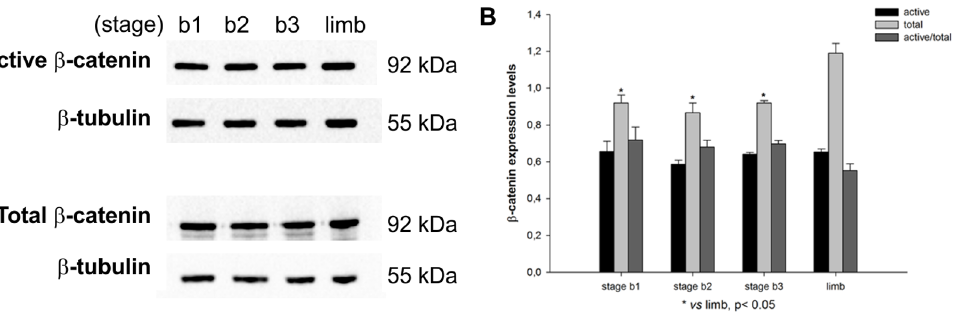
Figure 4. Activity of Wnt/ b -catenin pathway in the embryonic chick lung. (A) Western blot analysis of active and total b -catenin in stage b1, b2 and b3 lungs, and stage 24 limb (as positive control). Control loading was performed using b -tubulin (55 kDa). Total and active b -catenin correspond to 92 kDa. (B) Semi-quantitative analysis for active and total b -catenin. Results are presented as arbitrary units normalized for b -tubulin. p , 0.05: * vs limb.